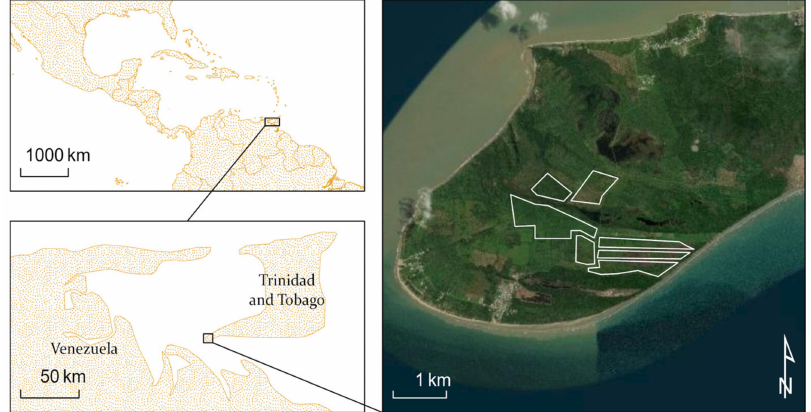
Figure 5. Coconut palm plantation in Trinidad shown in a true color Google Earth image. The area outlined in white was selected for data retrieval from Google Earth